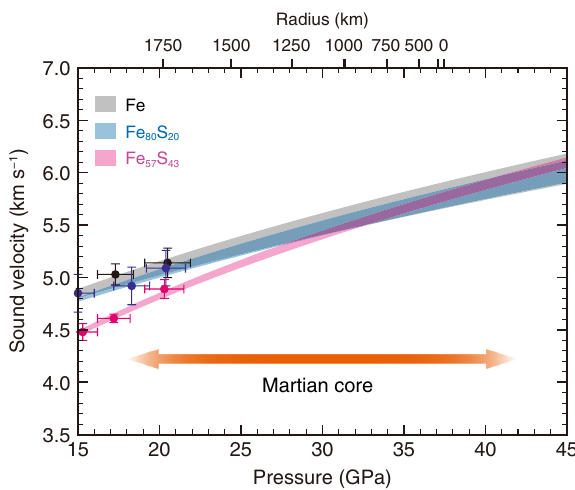
Fig. 3 Pressure effect on V P in liquid Fe-S under Martian core conditions. Hatched areas denote the ranges of V P in liquid Fe (gray), Fe 80 S 20 (blue) and Fe 57 S 43 (pink) extrapolated with and without using shock-wave data. Radius is based on ref. 2 .